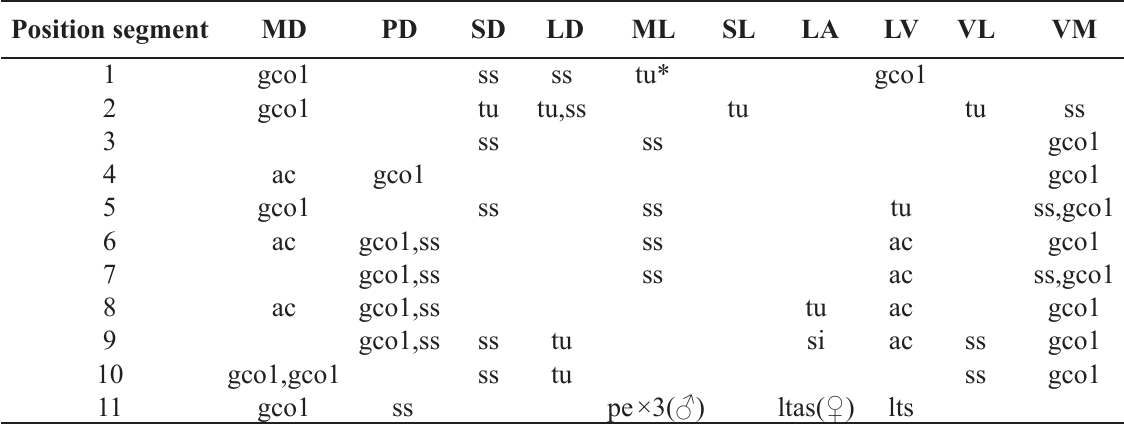
Table 13. Summary of nature and location of sensory spots, glandular cell outlets, tubes and spines arranged by series in Echinoderes frodoi sp.